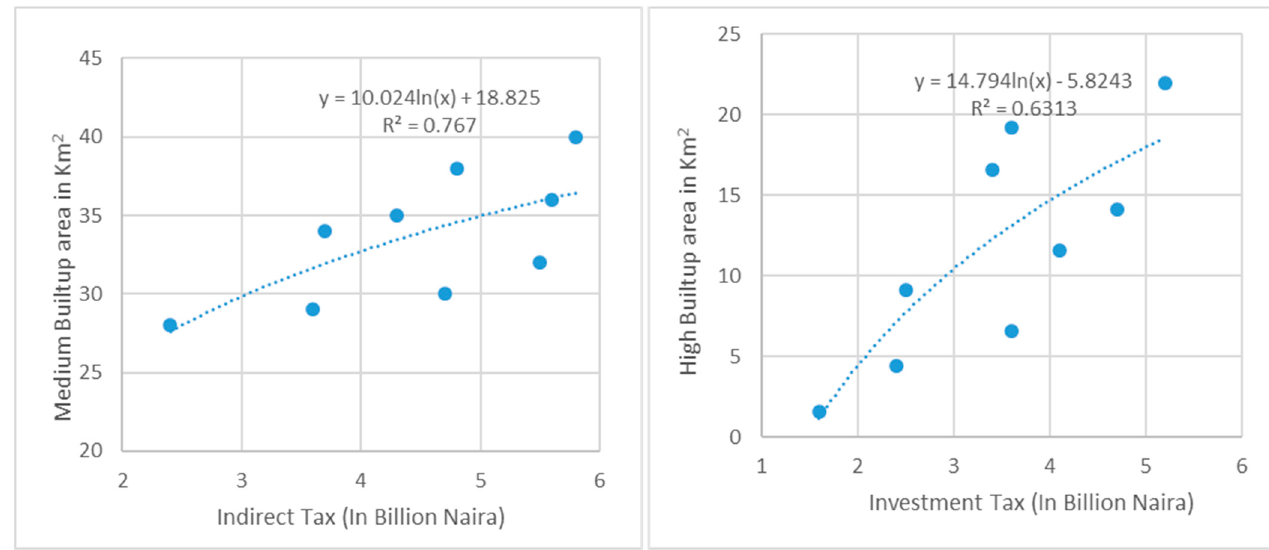
Figure 3. Relationship between socioeconomic variables and medium-density built-up areas in Uyo from 2010 to 2018.